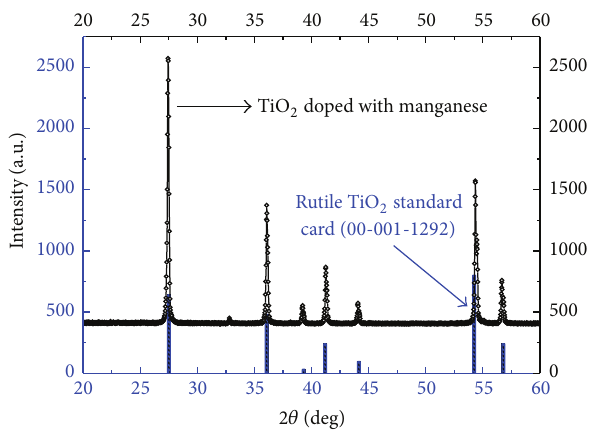
Figure 2: Comparison of XRD pattern of rutile TiO 2 standard card (PDF number 00-001-1292) and TiO 2 doped with manganese oxalate.